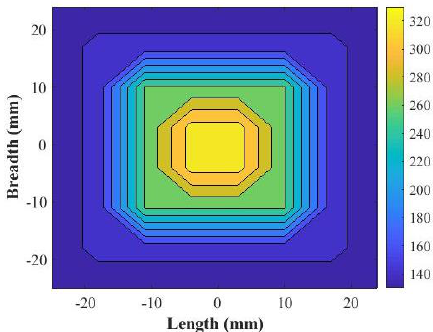
Figure 2. Distribution of the phase as noticed above the ground plane in the 12 GHz designed